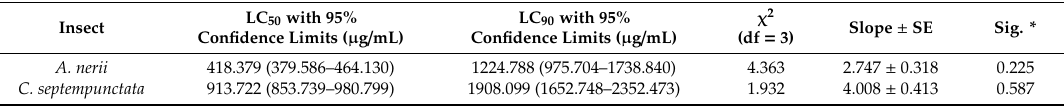
Table 5. Probit analysis of the data obtained from contact toxicity of Satureja intermedia essential oil on the adults of Aphis nerii and Coccinella septempunctata